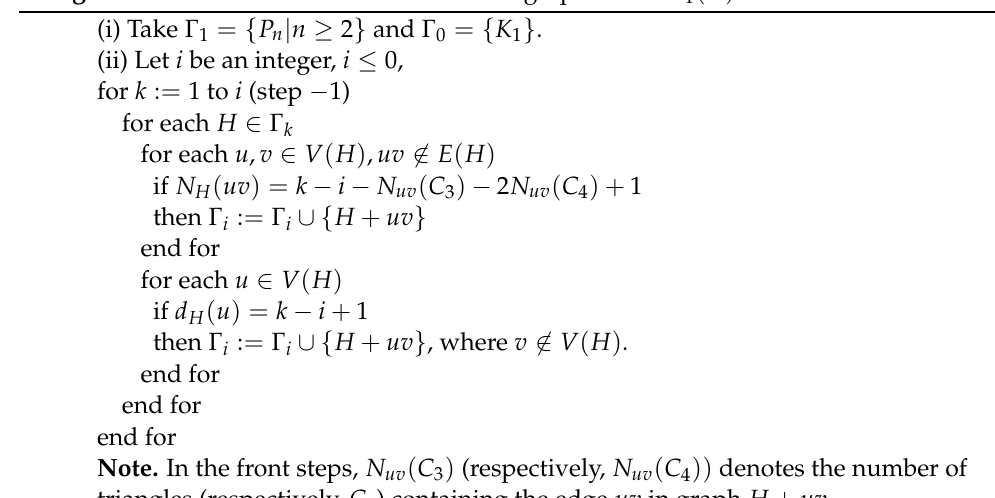
Algorithm 1: Construction of all connected graphs with Π 1 ( G ) = i